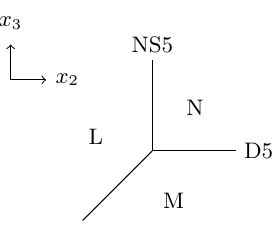
Figure 1 . This (cid:12)gure is illustrated on x 2 - x 3 plane. D3 branes extend also along x 0 and x 1 directions. 5-branes extend along 01456 directions in addition to the direction described above. We recommend the readers to see (cid:12)gure 1 in [9] for more